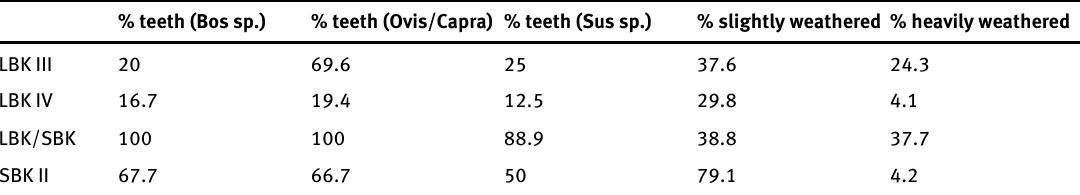
Table 3. Proportion of teeth of main ungulates and animal remains damaged by weathering in different chronological stages. % teeth (Bos